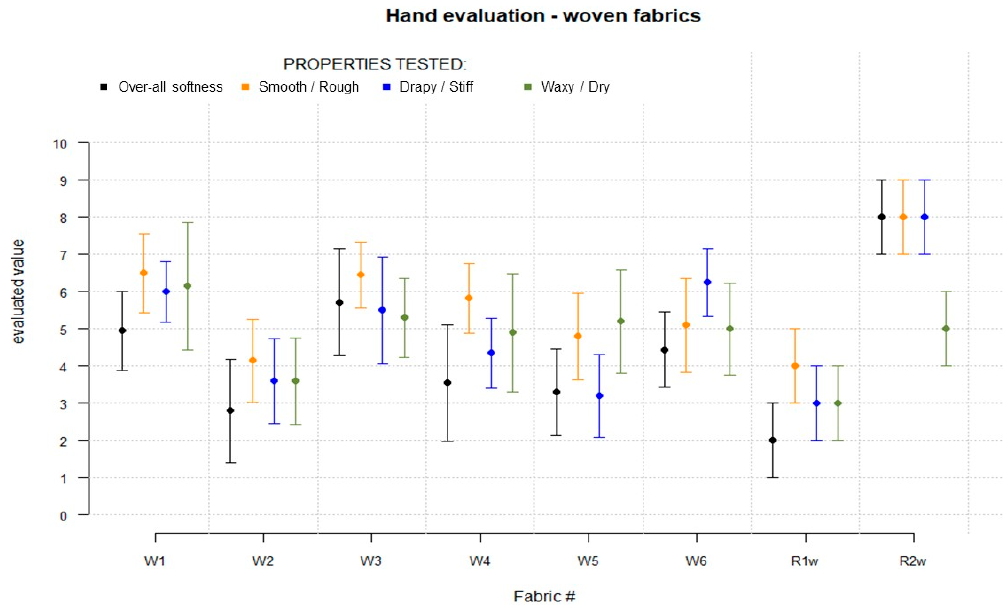
Figure 5. Average results and SD for each woven fabric and each property.